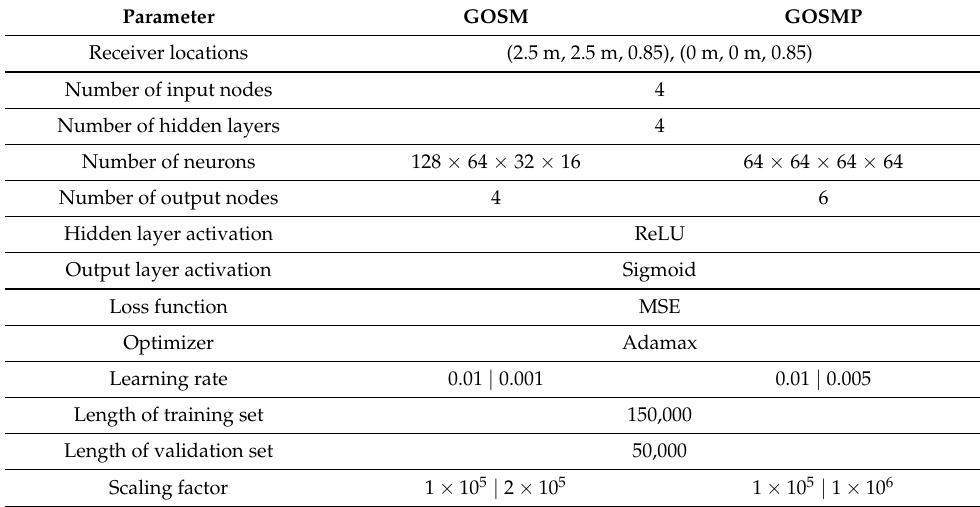
Table 2. Parameters of the DNN detector for GOSM and